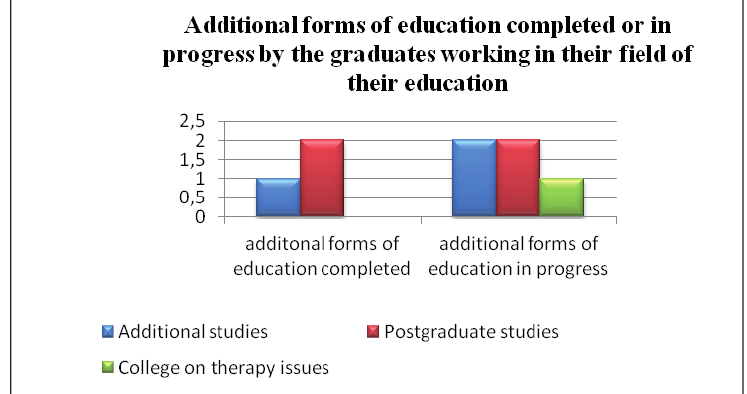
Fig. 4. Additional forms of education fi nished and already taken by the